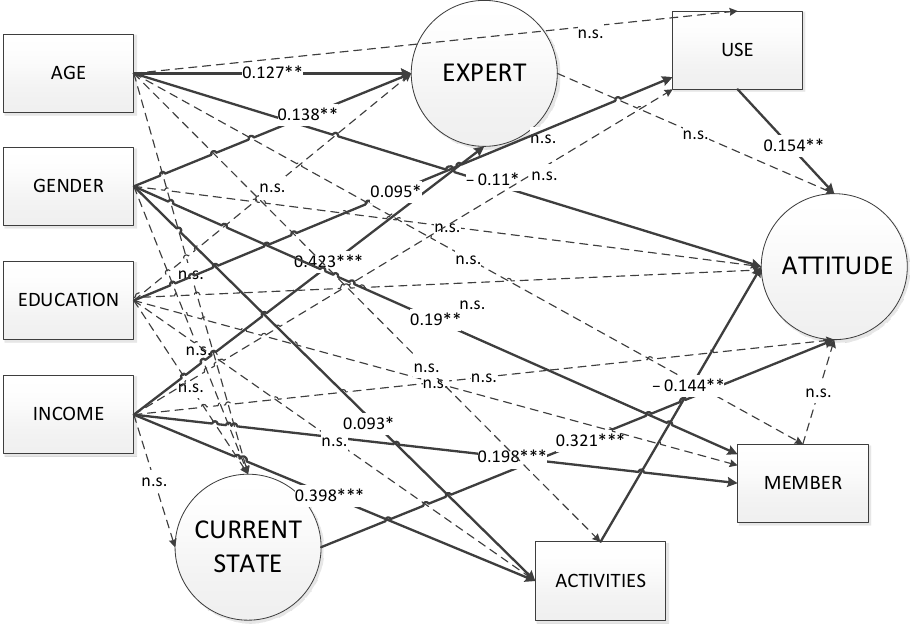
Figure 7. Estimated parameters along with corresponding statistical significance (Model F). * parameter is significant at the 10% significance level. ** parameter is significant at the 5% significance level. *** parameter is significant at the 1% significance level. n.s.: non-significant.